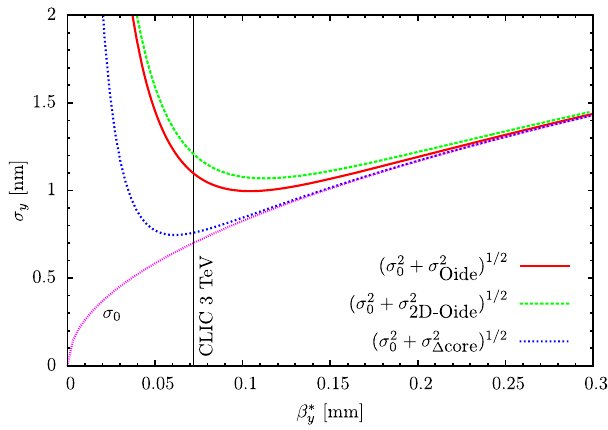
FIG. 4. Beam size as a function of β (cid:1) y . The current design value for CLIC 3 TeV is β (cid:1) y ¼ 0 . 07 mm.